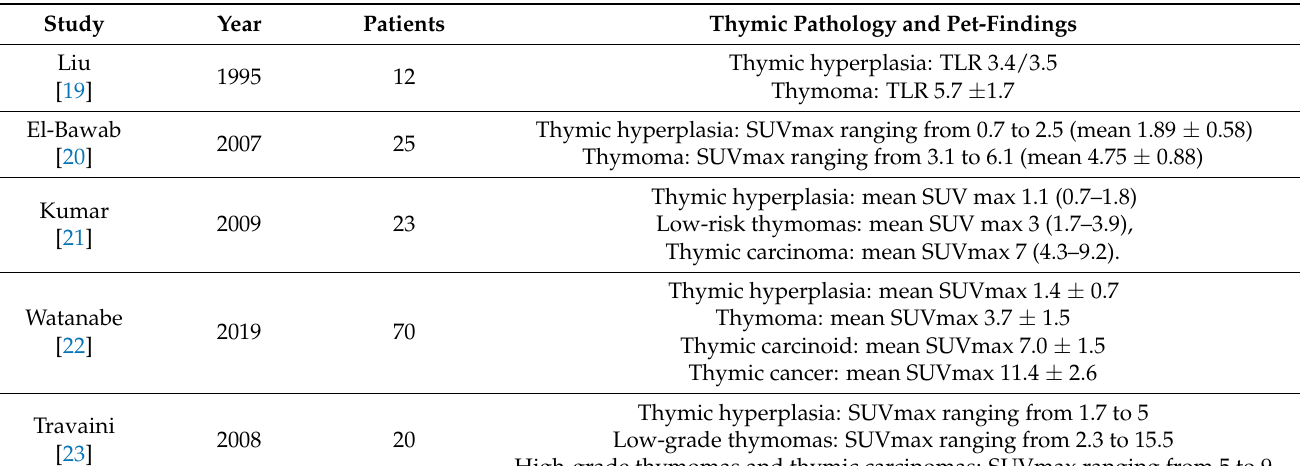
Table 1. PET parameters and thymic pathological findings (hyperplasia vs. tumour) (TLR: tumour to lung ratio).